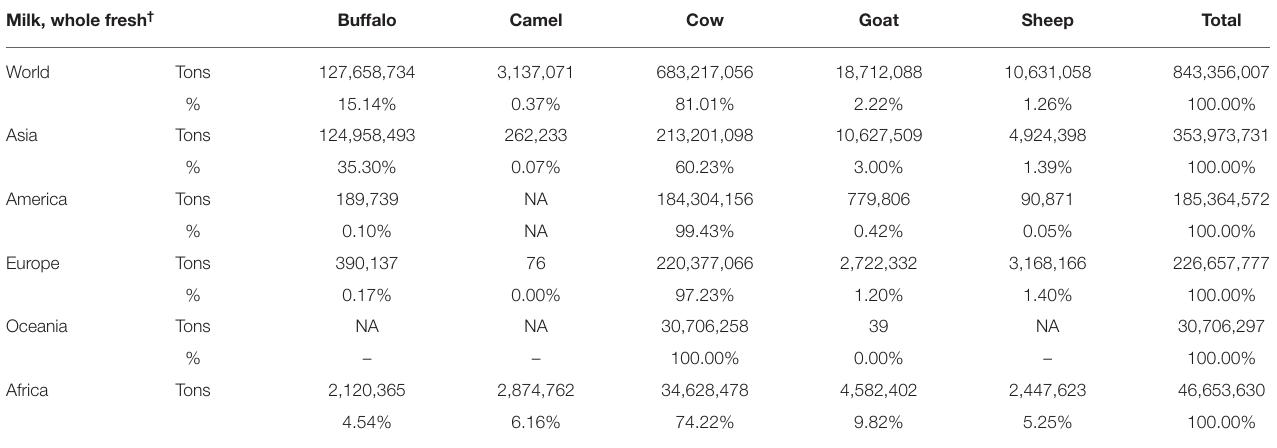
TABLE 3 | Buffalo, camel, cow, goat, and sheep milk whole fresh produced in 2018 for each